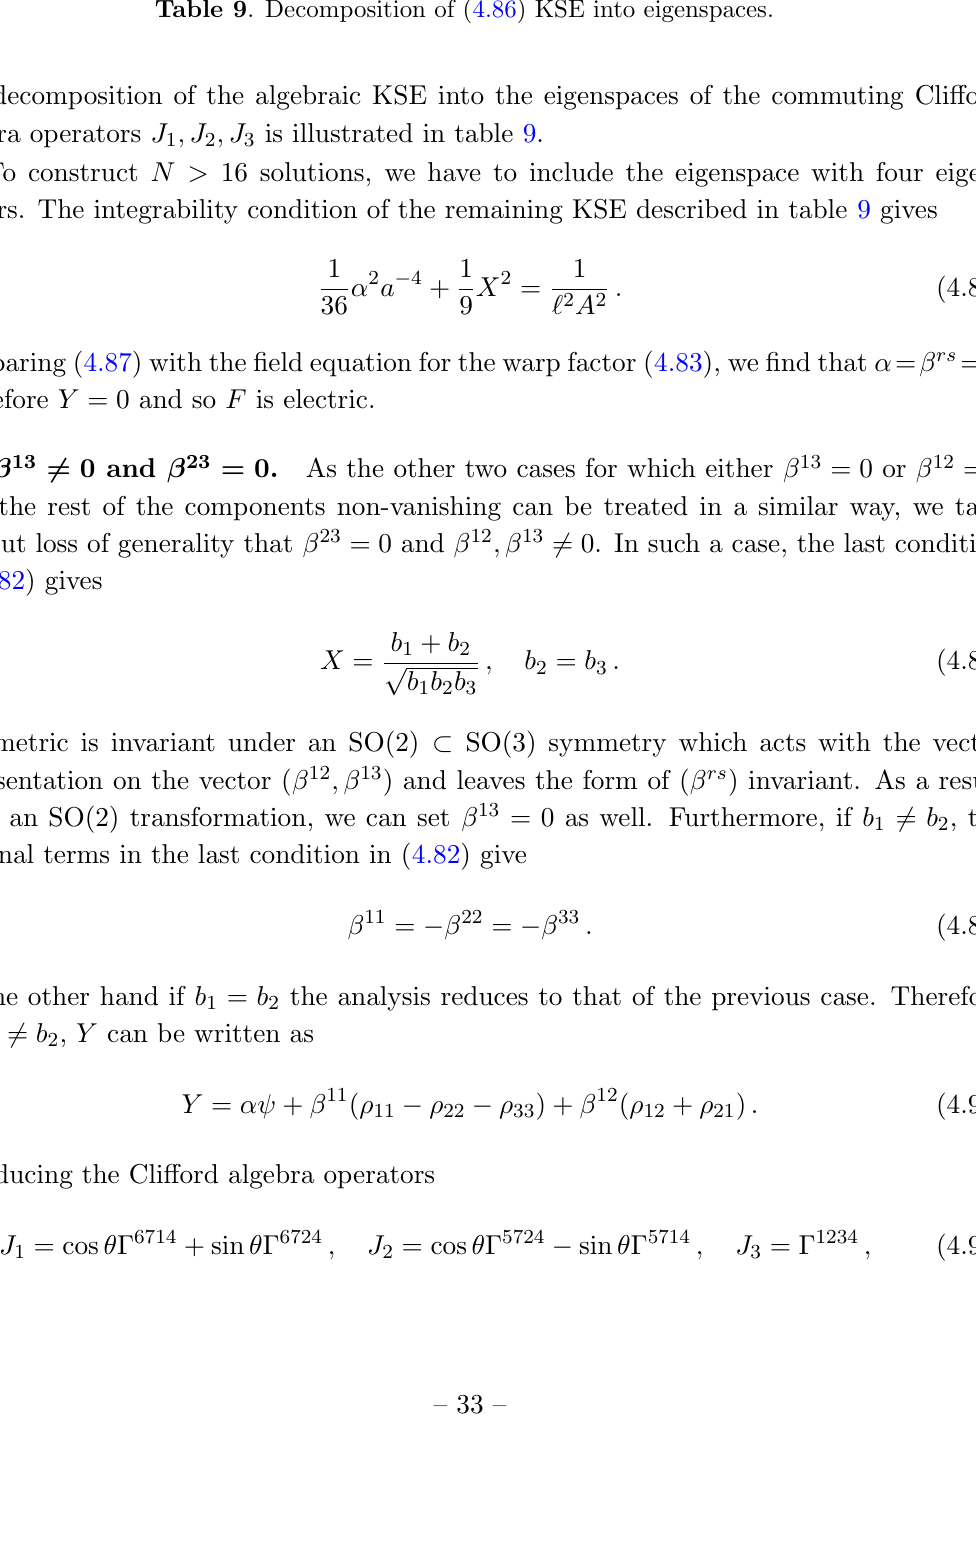
Table 9 . Decomposition of (4.86) KSE into